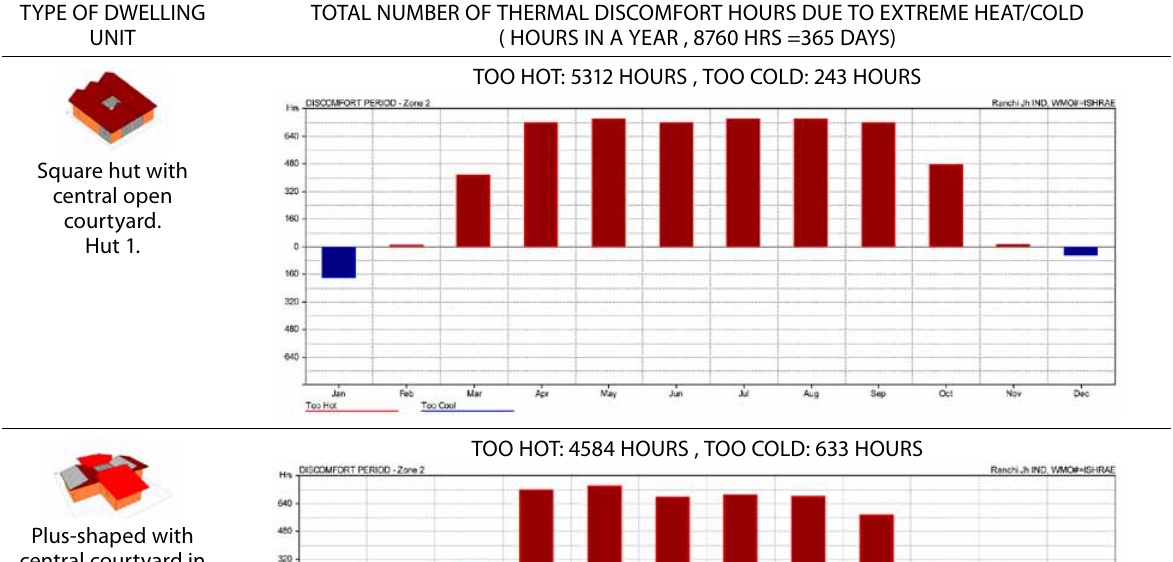
Table 4. Detailed number of discomfort hours through the day (summer and winter) for the three dwellings TYPE of DWEllInG unIT